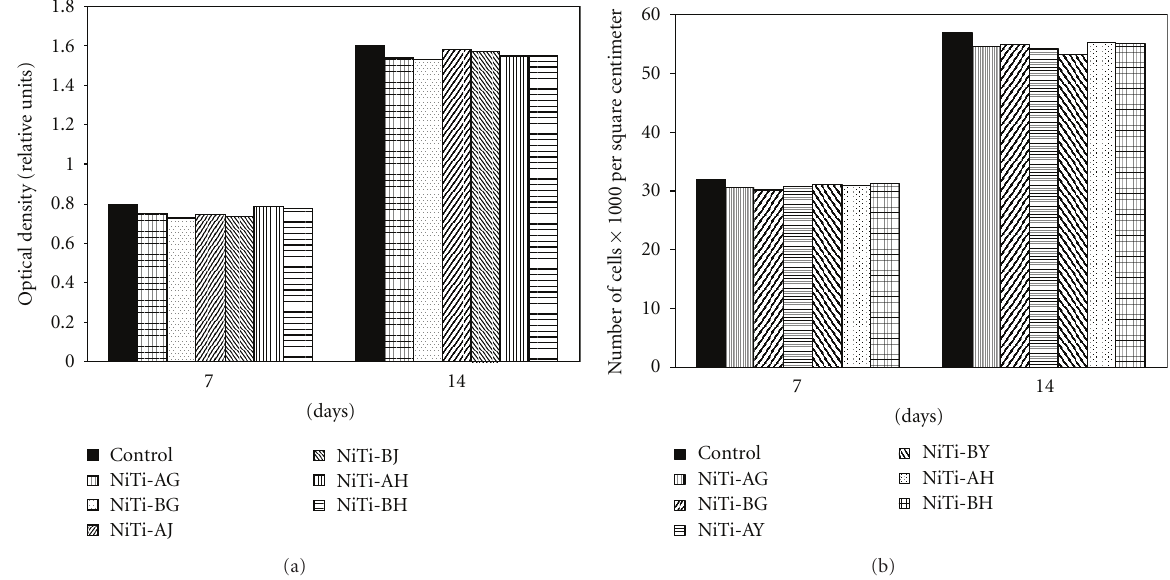
Figure 9: E ffi ciency of MSC proliferation with the NiTi specimens: MTT test (a), cell counting in the Goryaev chamber (b); control cells cultivated with no specimen (cell control